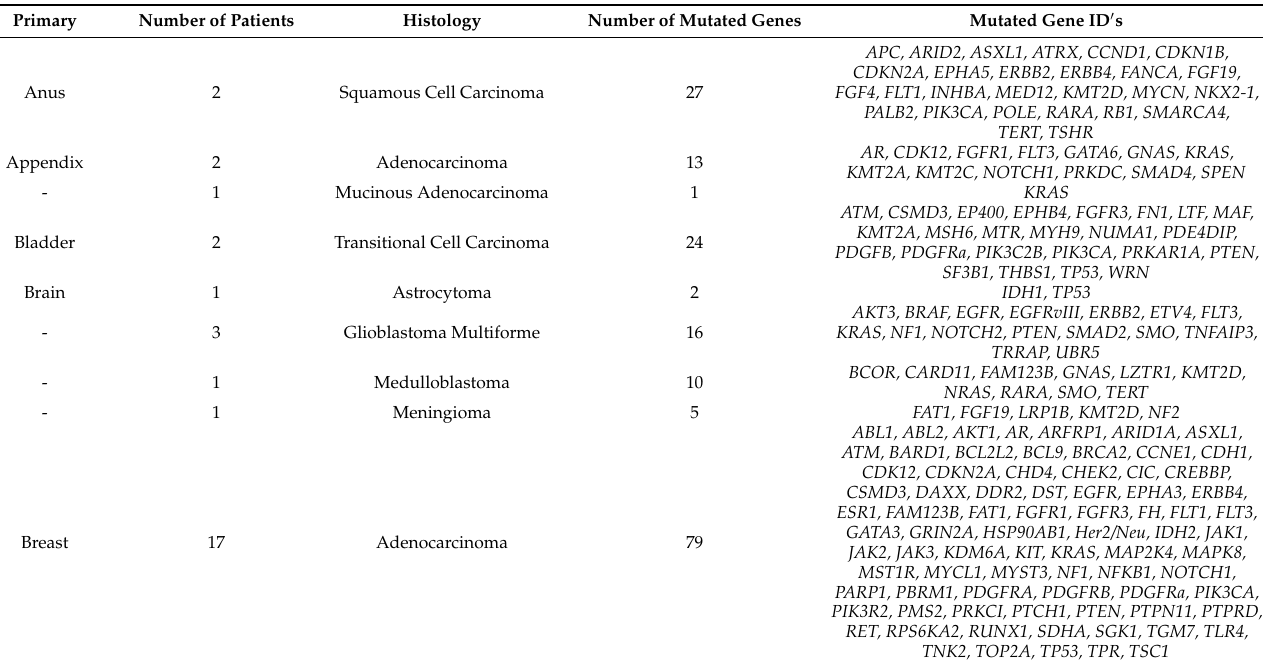
Table 1. Molecular profiles of advanced cancer patients enrolling in phase I